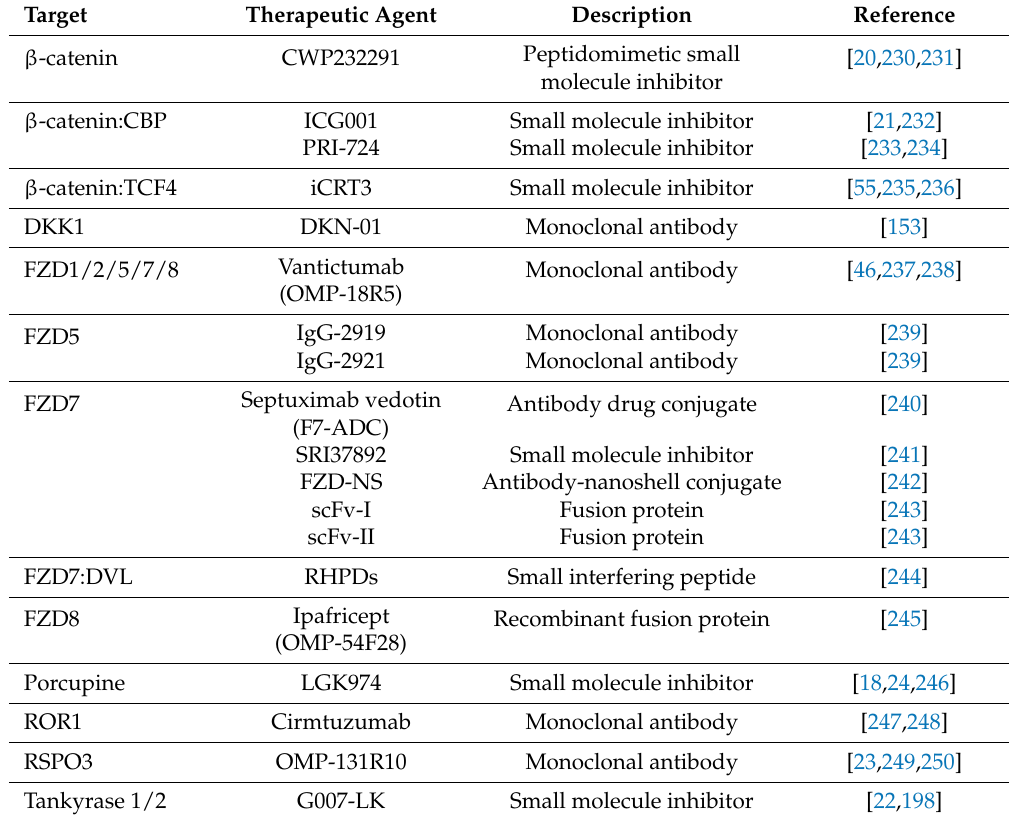
Table 3. Selected promising Wnt pathway-directed